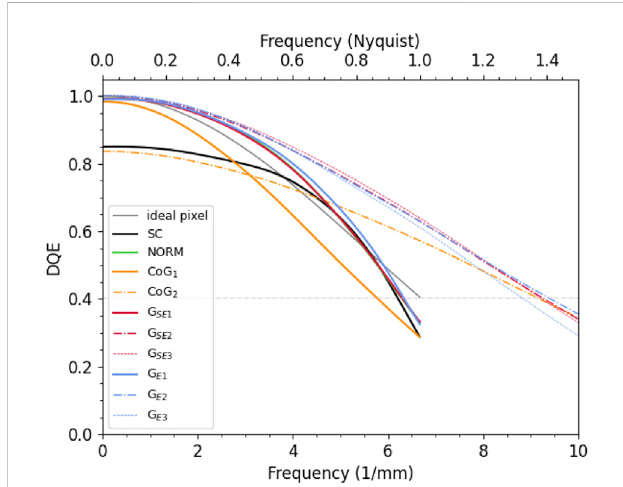
FIGURE 9 DQE for the different probed processing methods. The frequency range is expressed both in absolute values and as a fraction of the physical Nyquist limit of the